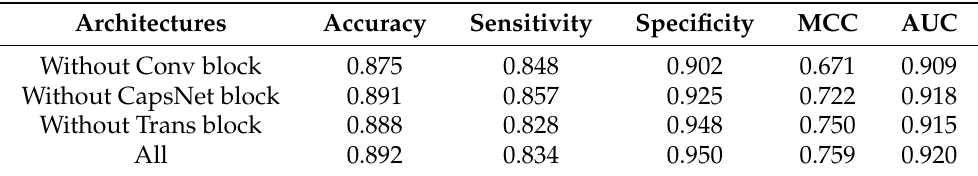
Table 8. Performance of different architectures for predicting saliva-secretory proteins on the train- ing set.